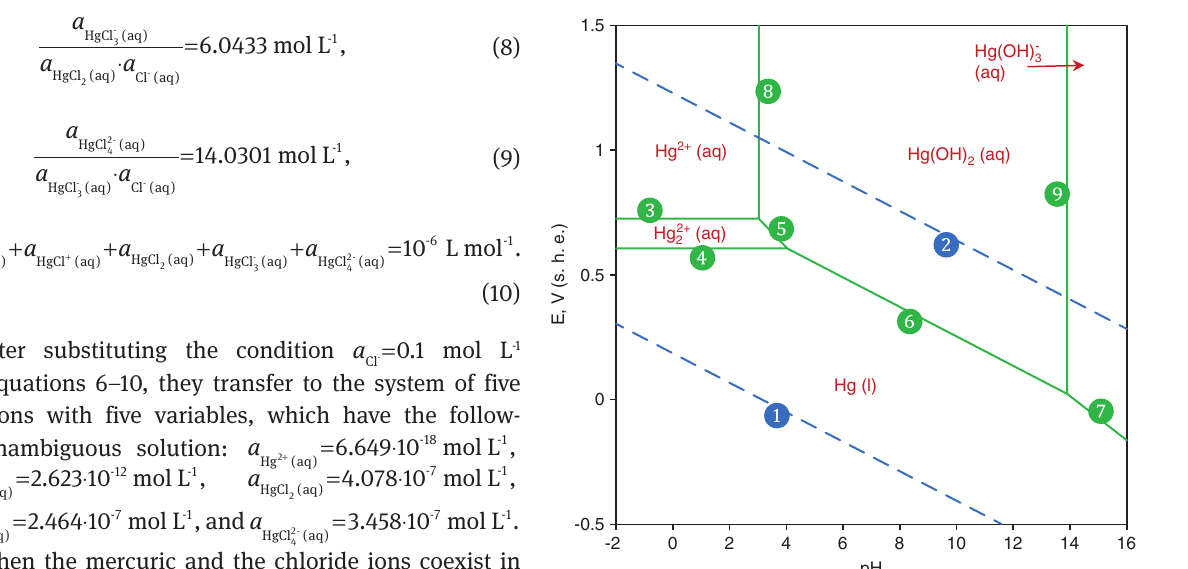
Figure 1: The potential-pH diagram of 2 and 1 bar.